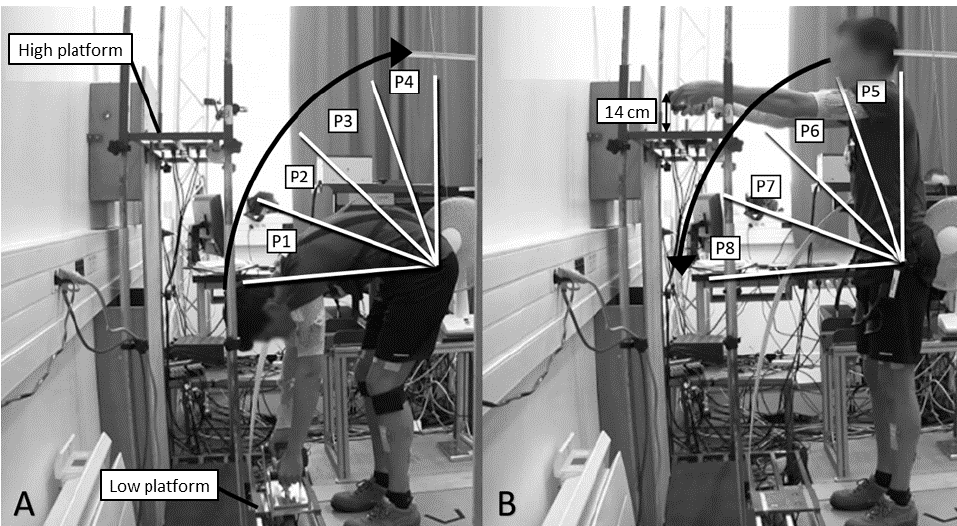
Figure 1. Experimental task performed. The range of motion of trunk sagittal inclination (TSI) was divided into four equal parts for the lifting action ( A : low (P1) to high platform (P4)) and for the lowering action ( B : high (P5) to low platform (P8)).